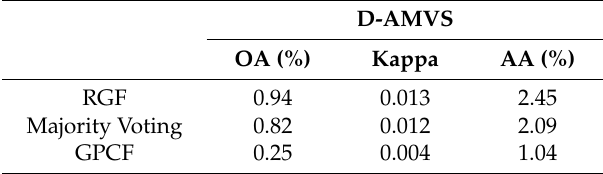
Table 9. Error estimation among the different methods for the Pavia Center image data.